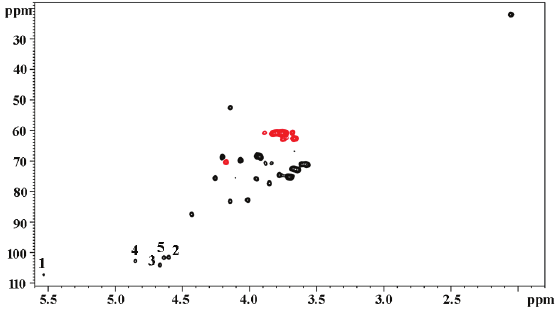
Figure 6 - 1 H- 13 C HSQC spectrum of the pentasaccharide alditol from epimatigotes of T. cruzi strain Silvio X10/1 (CH black, CH red). 1. Gal f -β-1-4-GlcNAc-ol; 2. Gal p -β-1-6- 2 GlcNAc-ol; 3. Gal p -β-1-2-Gal p ; 4 Gal p -β-1-3-Gal p ; 5. Gal p - β-1-2-Gal f